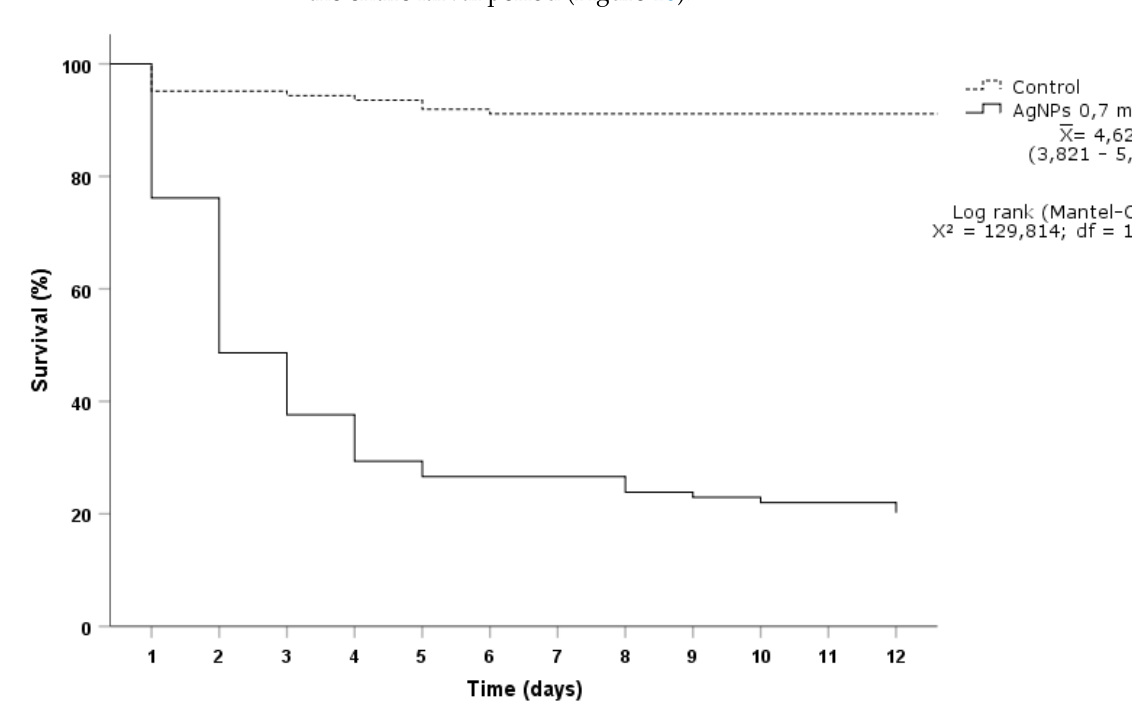
Figure 10. Survival curve of Plutella xylostella caterpillars treated with Isaria fumosorosea